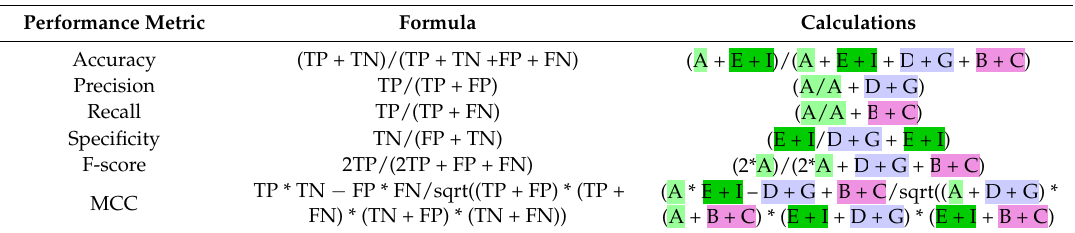
Table 9. Performance metrics extracted from confusion matrix for class 1